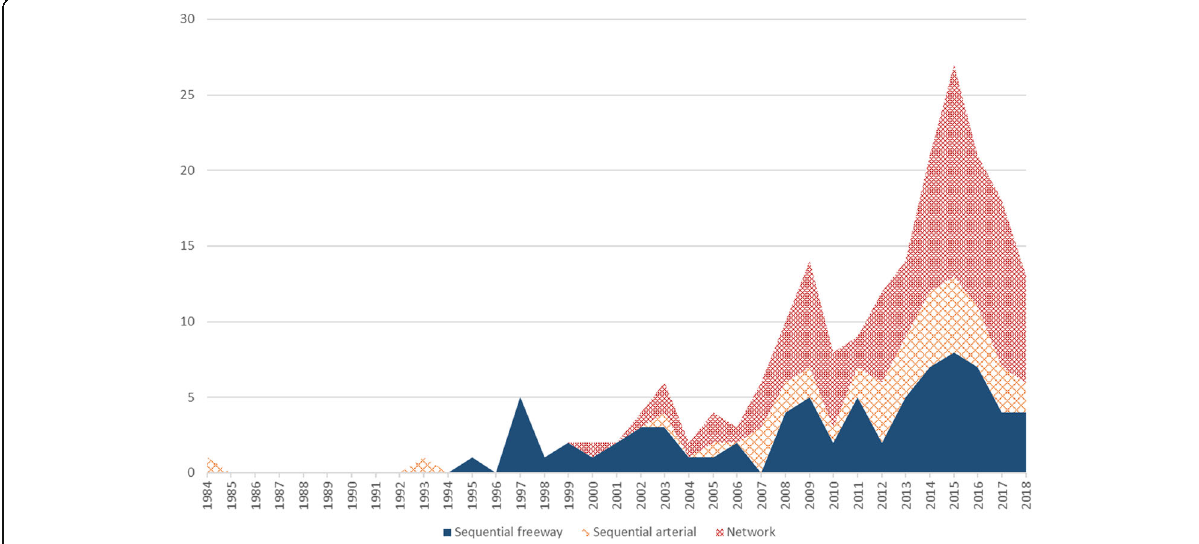
Fig. 2 Dynamics of analysed road network